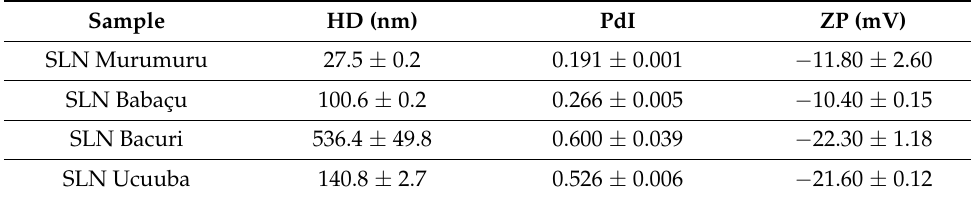
Table 4. HD, PdI, and ZP obtained with previous SLNs.